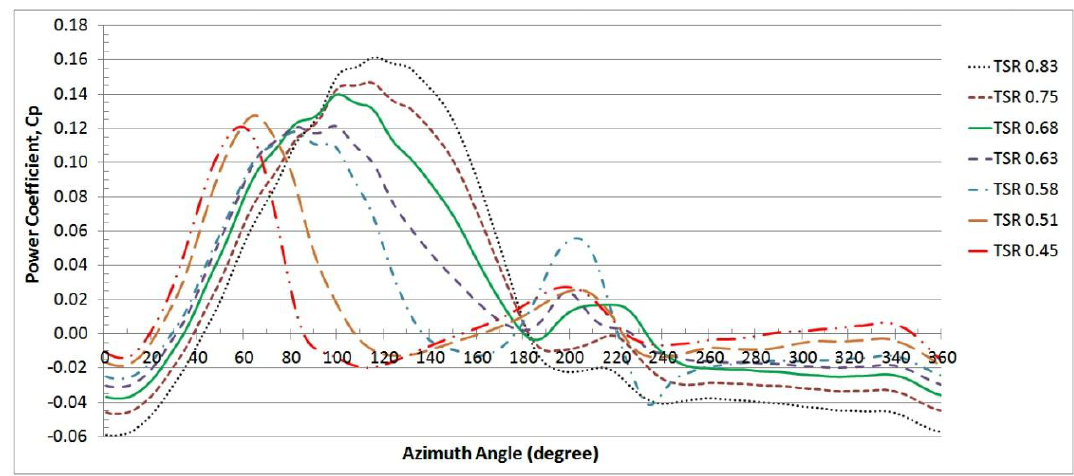
Figure 22. Power coefficient of a single blade of the VAWT versus azimuth angle.